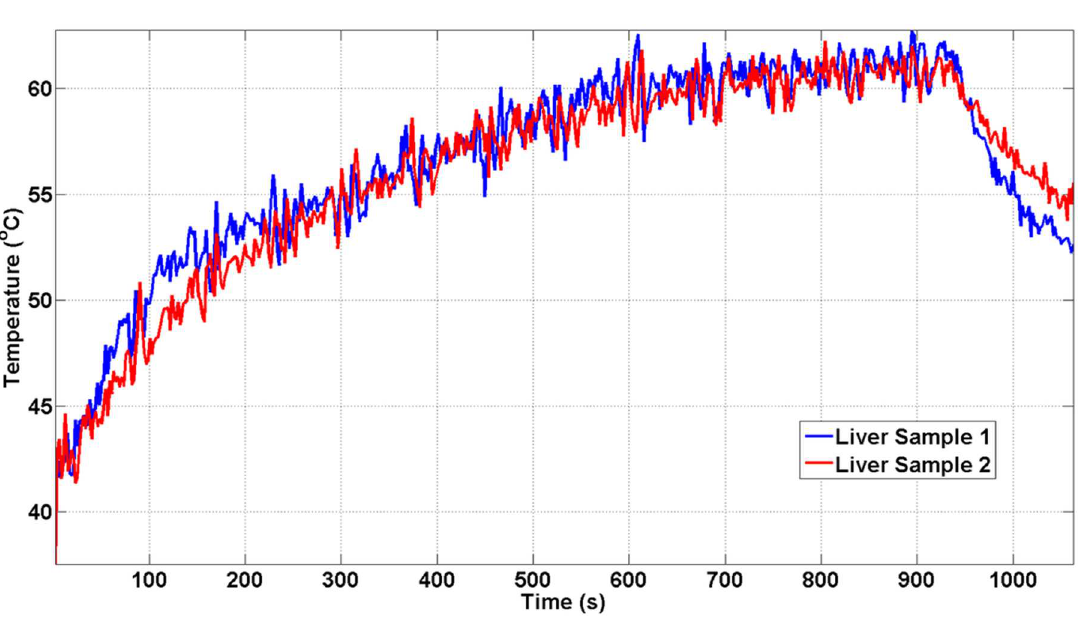
Fig 8. Temperature change measuredat the first coronal slice for separateliver samples. The sonicationparameters for both liver samples were 650 W of acoustic power, 15,000 cycles/pulse at 1 Hz PRF. The peak temperature was reachedat the end of the sonication(64˚C). Both temperature curves show similar